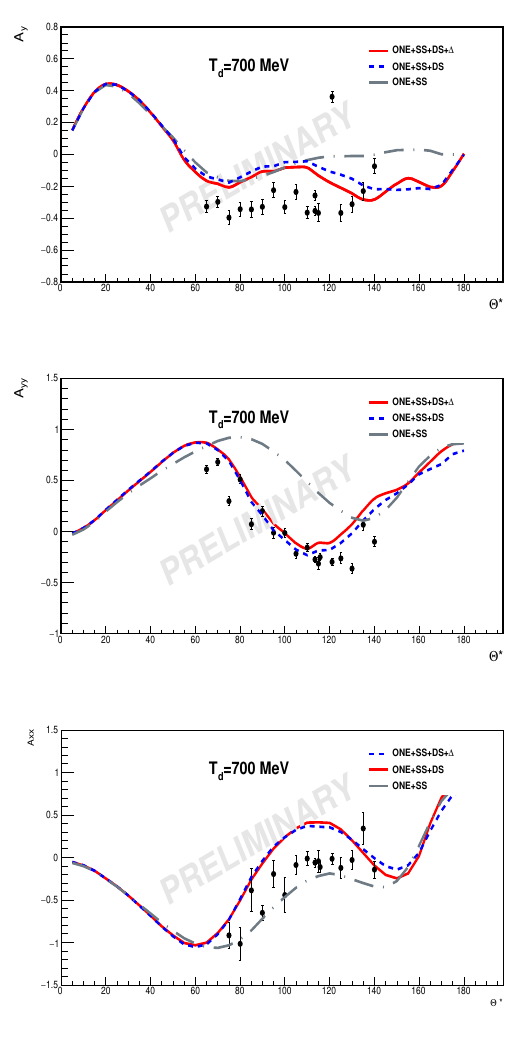
Figure 6. The angular dependence of the vector analyzing power A y at the deuteron kinetic energy T d of 700 MeV. The full symbols are the preliminary results of the DSS experiment at ITS at the Nuclotron. Curves are explained in the text